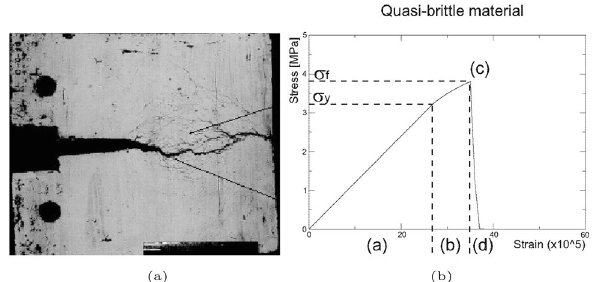
Fig. 23 a Typical quasi-brittle fracture pattern in quasi-brittle mate- rials with fracture process zone (FPZ) and macro-crack; b 1D model representation of fracture behavior for quasi-brittle material in ten- sile test